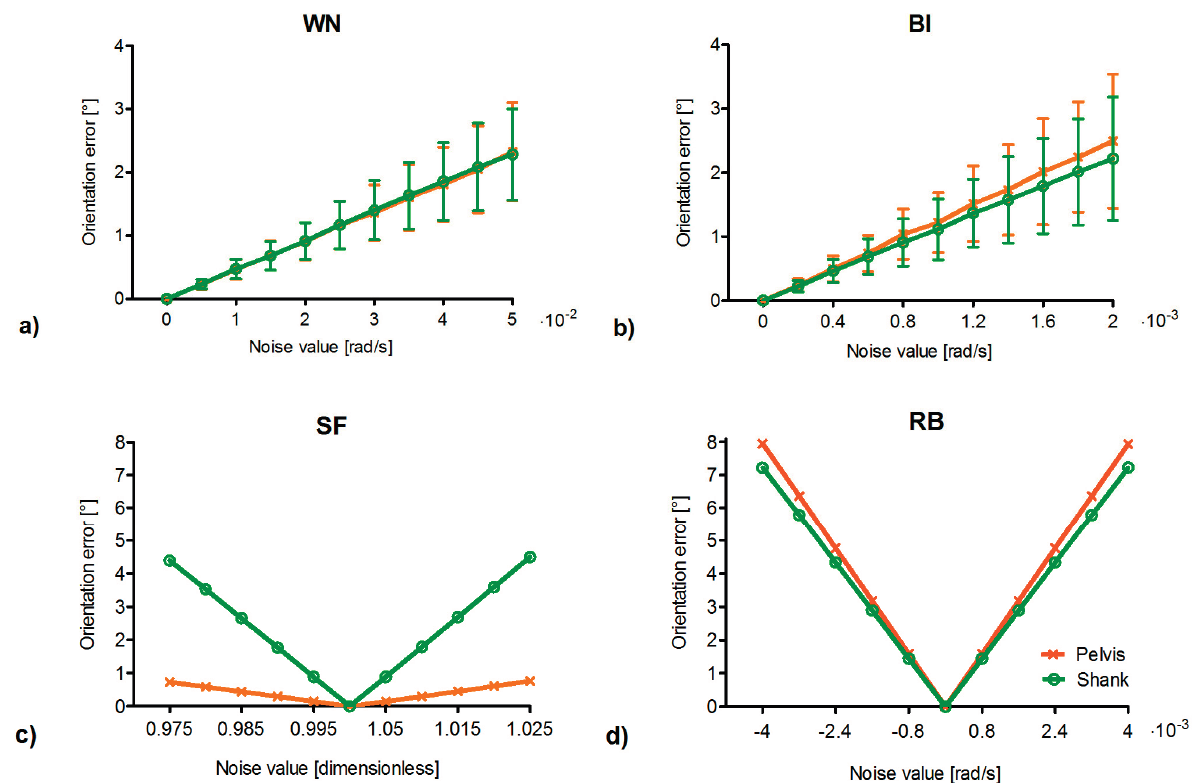
Figure 3. Orientation error associated to each homogeneously distributed noise type as a function of noise levels for the ideal pelvis (orange) and shank signals (green). ( a ) WN: white noise; ( b ) BI: bias instability; ( c ) SF: scale factor; and ( d ) RB: residual bias. For WN and BI ( a , b ) the abscissae indicate the noise level values associated to each gyroscope axis, and the orientation error is reported as mean and standard deviation (vertical bars) corresponding to the five hundred simulation runs of each noise level. For SF and RB ( c , d ) the abscissae indicate the magnitude of the noise level values. Noise levels